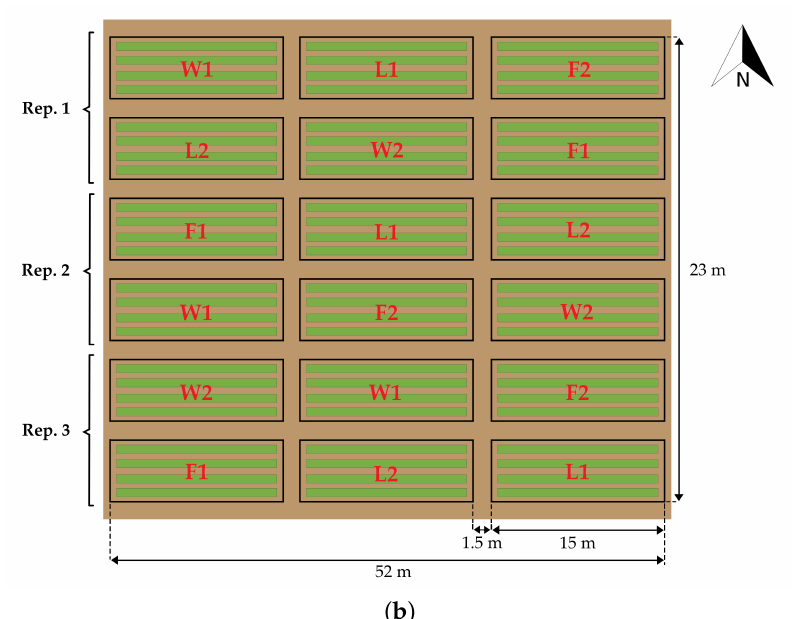
Figure 2. Outlined plots and matching cultivars along with field and plot design dimensions for ( a ) 2019 and ( b ) 2020 experimental designs. Listed here are the Venture (large cultivar variety 1; L1), Huntington (large cultivar variety 2; L2), Colter (four sieve cultivar 1; F1), Cabot (four sieve cultivar 2; F2), Flavor-sweet (whole bean cultivar 1; W1), and Denver (whole bean cultivar 2; W2). Schematics are not to